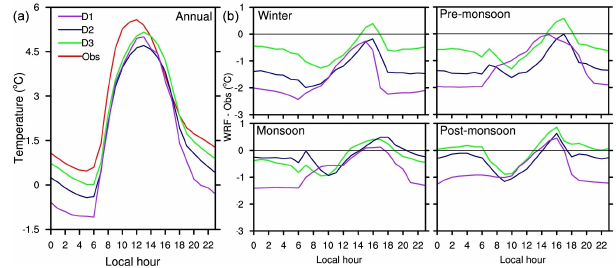
Figure 8. Diurnal mean annual temperature (a) and biases of tem- perature in all four seasons (b) at three WRF